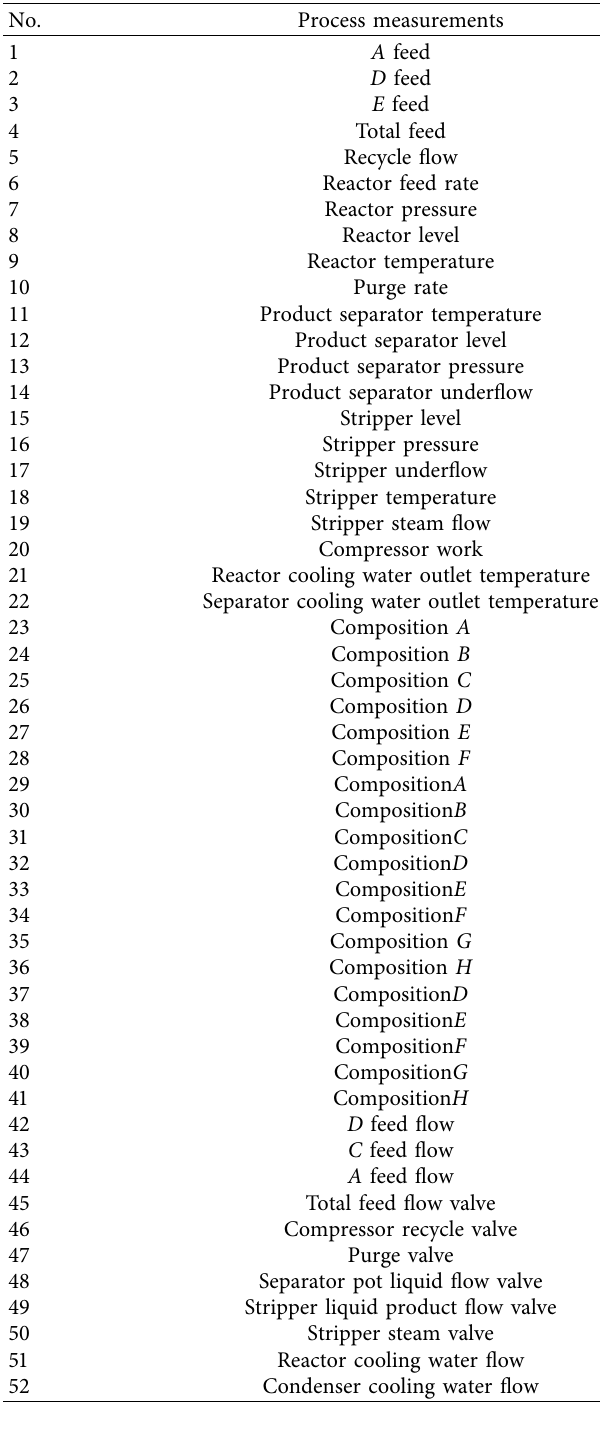
Table 1: Process variables in the TE process. Table 2: Faults of the TE